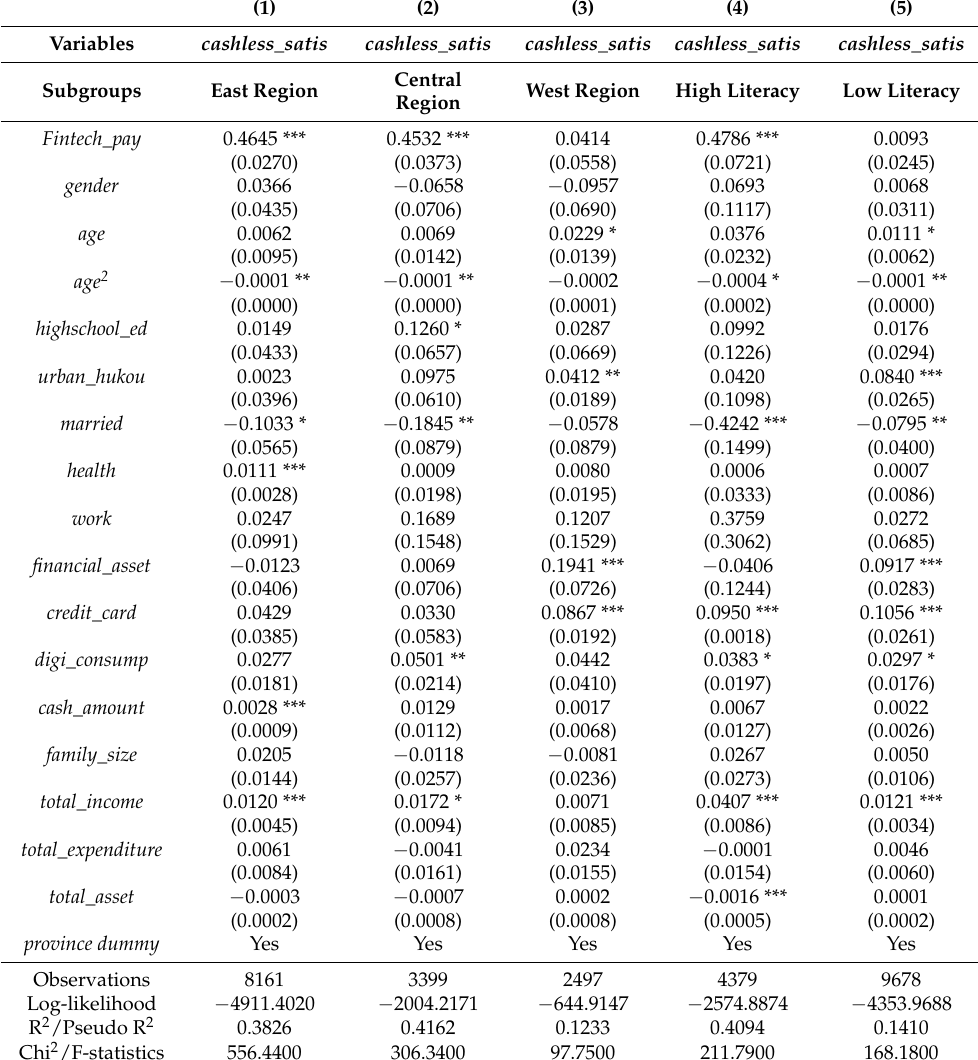
Table 5. Heterogeneity in terms of location and financial